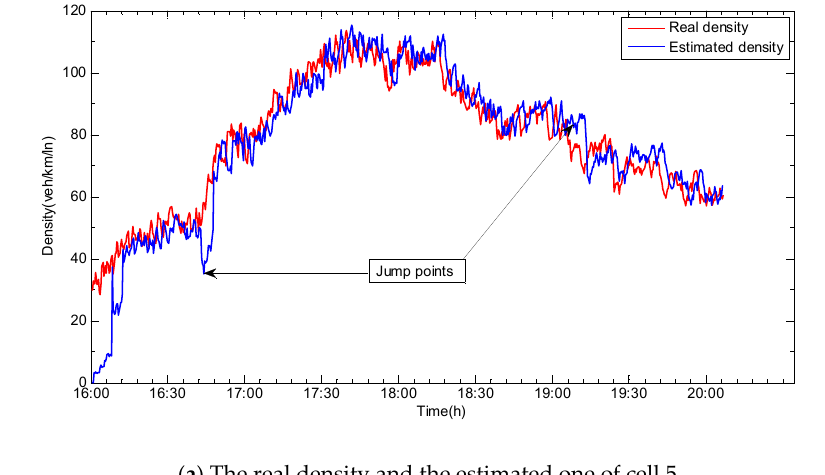
( a ) The real density and the estimated one of cell 5.